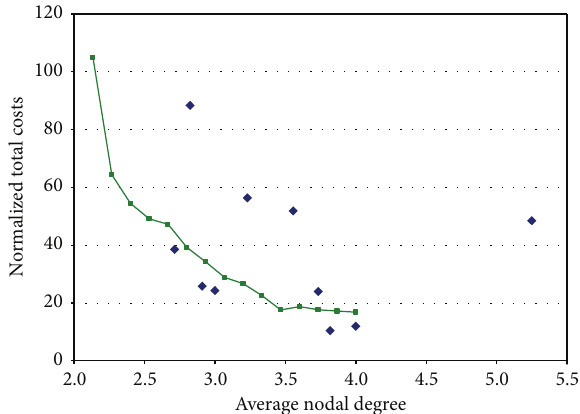
Figure 14: Normalized path restoration SCA spare capacity costs.